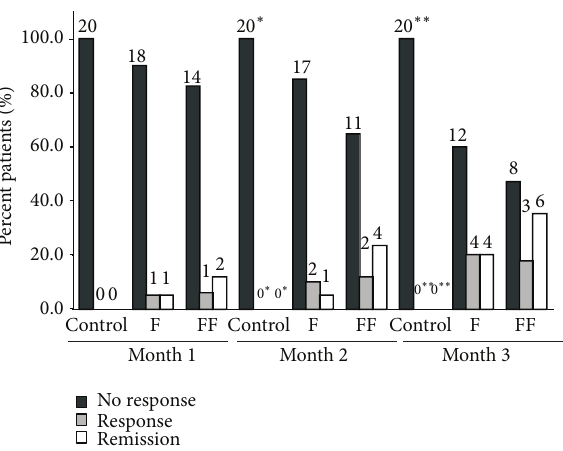
Figure 1: ∗ 𝑃 < 0.05 compared to baseline; ∗∗ 𝑃 < 0.05 compared to control group. 𝑃 values from ANCOVA with baseline values as covariate.